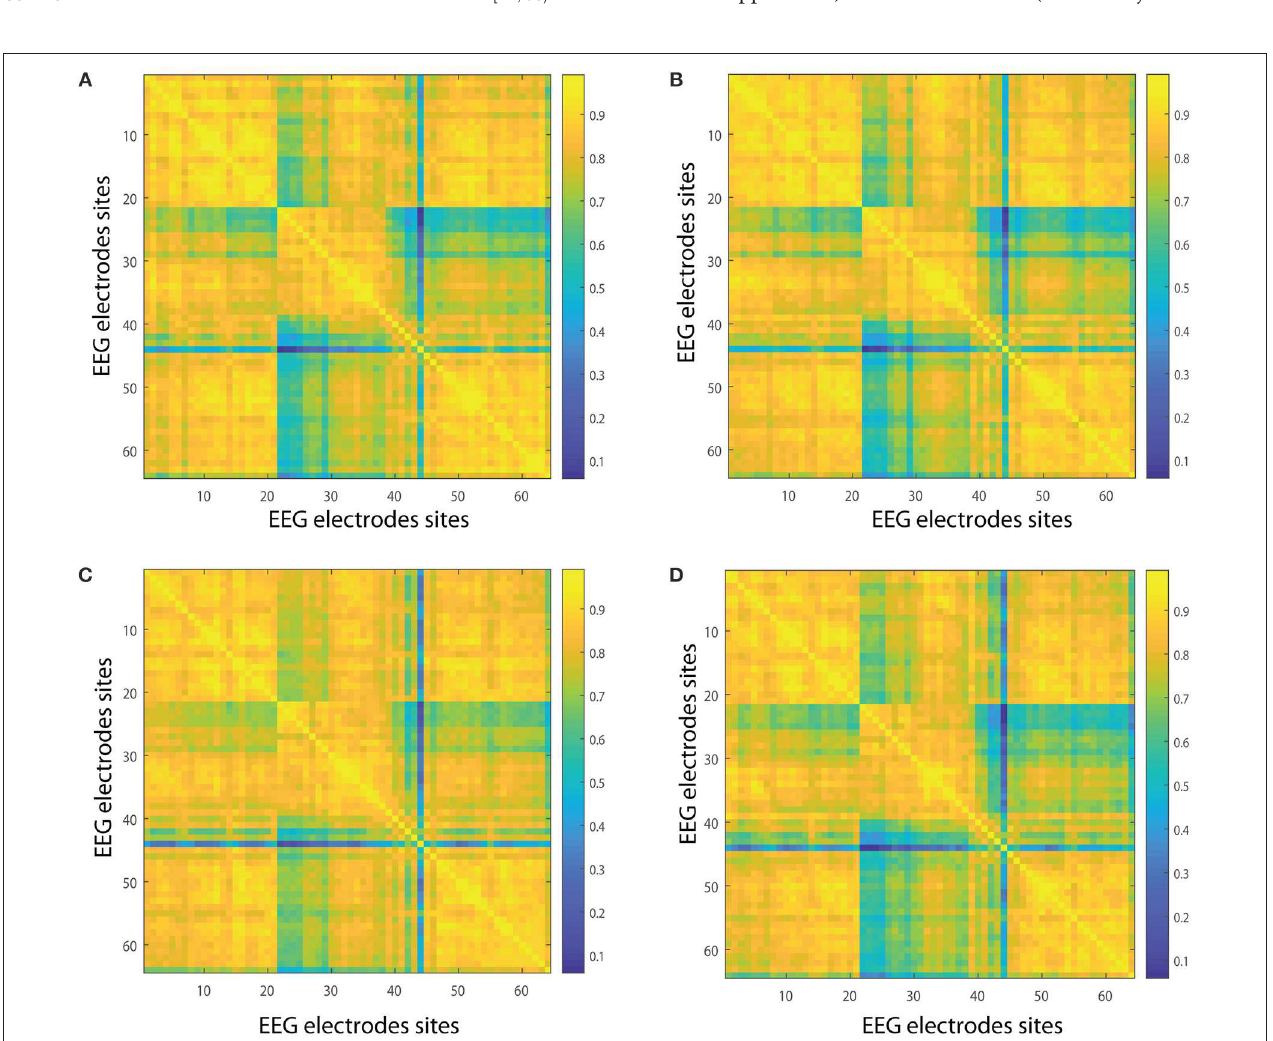
FIGURE 2 | Network interconnectivity. (A,B) Show the network averaged values of the interconnectivity considering 109 subjects when performing the visuomotor task for the 64-channel EEG considering the different oscillation bands delta and theta. (C,D) Are the same as (A,B) but considering the imagined task. We consider D = 6 and τ = 1. Delta oscillation band corresponds to [1,4) Hz and theta oscillation band to [4,8) Hz .